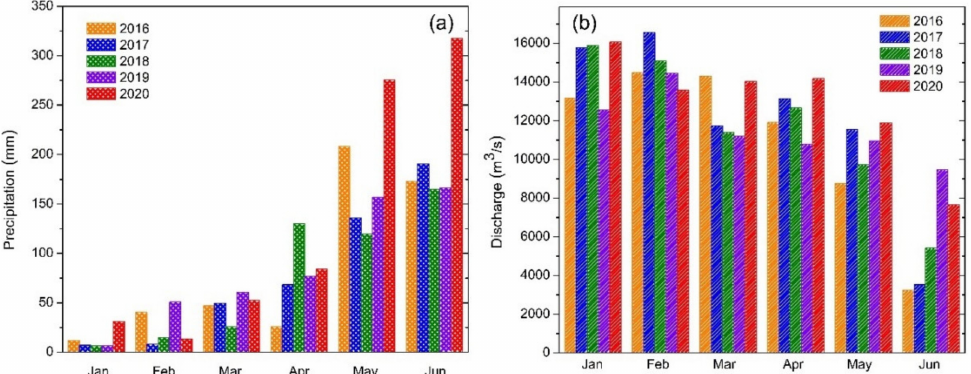
Figure 6. ( a ) Monthly mean rainfall data for the lower reaches of the Ganges river during 2016 and 2020. ( b ) Monthly mean Ganges river discharge from satellite-based estimates at a lower reach location (24.974 ◦ N, 87.975 ◦